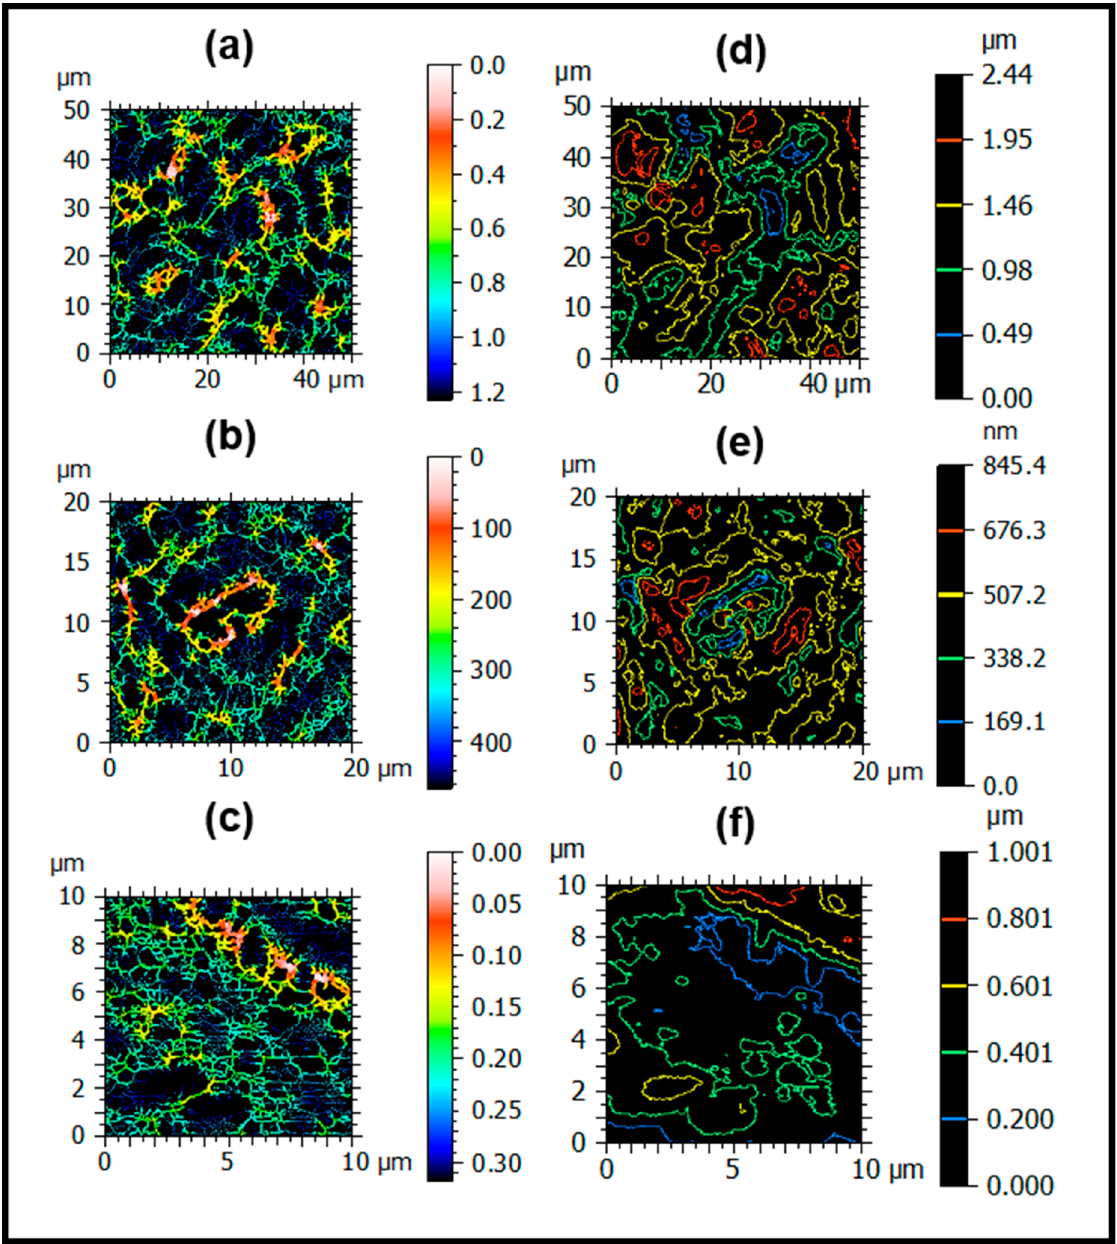
Figure 5. Graphical representations of the furrows ( a – c ) and contour lines ( d – f ) of S50, S20, and S10, respectively. The following renderings (Figure 5d–f) show contour lines around particles, wherein Figure 5e, the region where the largest hole was observed, is wholly flooded while the region where the guardian cells remained intact. Along the yellow contour lines, the fluid path leads to the bottom of the pore. Similar behavior can also be seen in Figure 5d. In the more planar image Figure 5f, the contour lines indicate more submerged regions. This fluid probably flows to the regions whose valleys are more prevalent, in other words, the pores. The regions between the pores Figure 5a,d appear to have more valleys. The highest maximum depth of furrow occurred for this image (0.8207 µm), which was confirmed for the mean depth (0.3016 µm), as shown in Table 3. However, the highest furrows density was noted for S10 (44,170 cm/cm 2 ), indicating a flatness and ordering of cells in the regions outside the pore. The fact that the image with the pore has a maximum depth furrow less